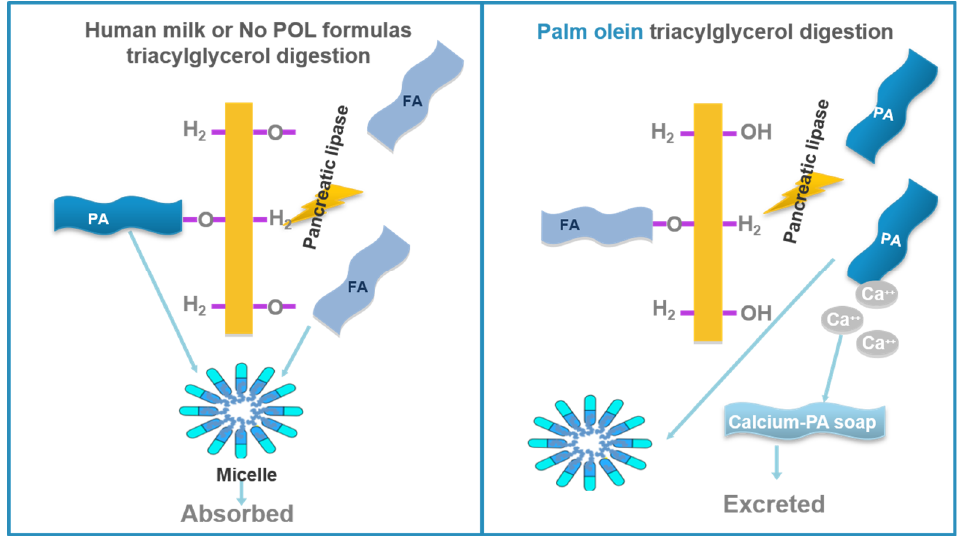
Figure 1. Comparative triacylglyceride digestion in human milk versus palm olein / palm oil based infant formulas. FA = fatty acid; PA = palmitic acid.